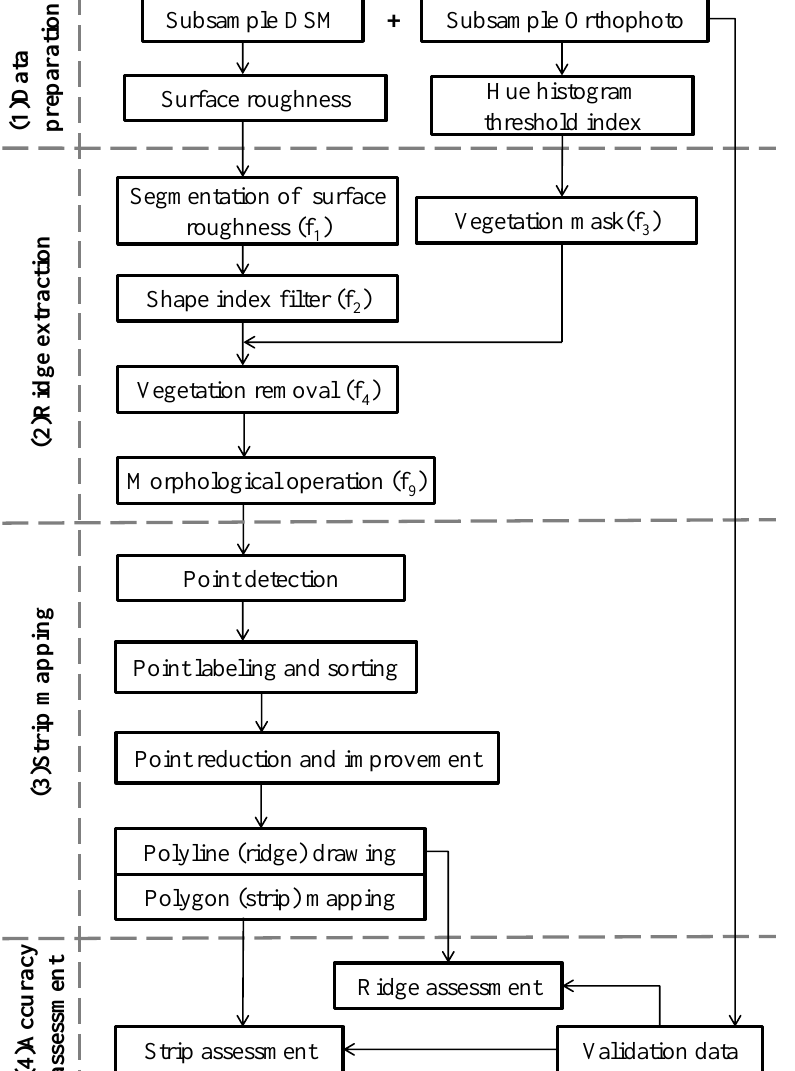
Figure 3. Pipeline of the methods used in this